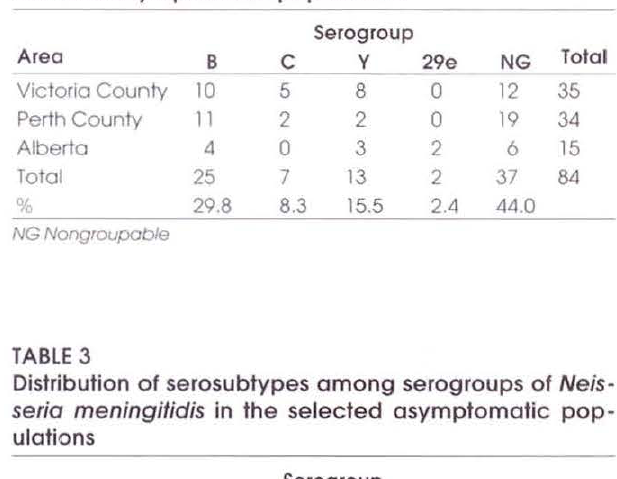
Distribution of Neisseria meningitidis by serogroup in the selected asymptom atic populations